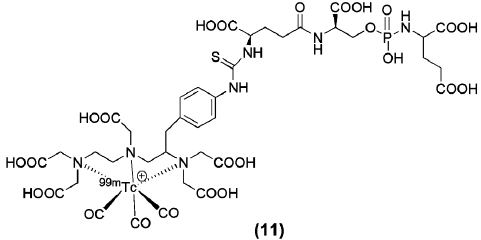
Figure 4. Chemical structure of 99m Tc(CO) 3 -DTPA-CTT-54 ( 11 ) [74].